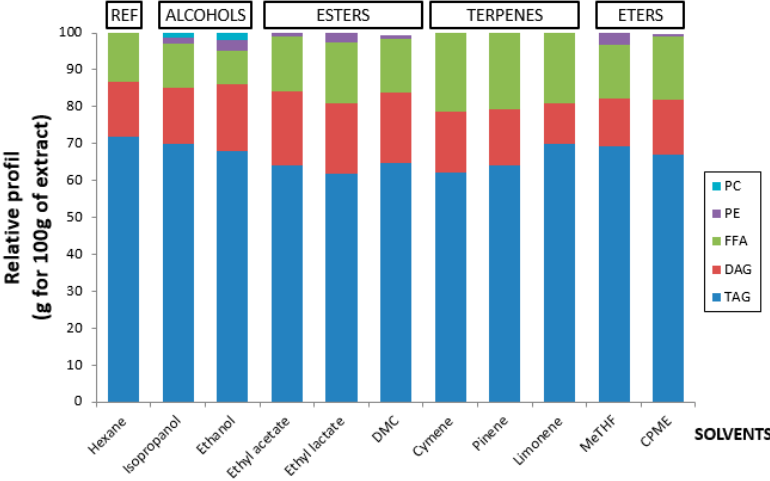
Figure 4. Comparison of lipid classes (TAG, DAG, MAG, FFA and PL) by HPTLC.